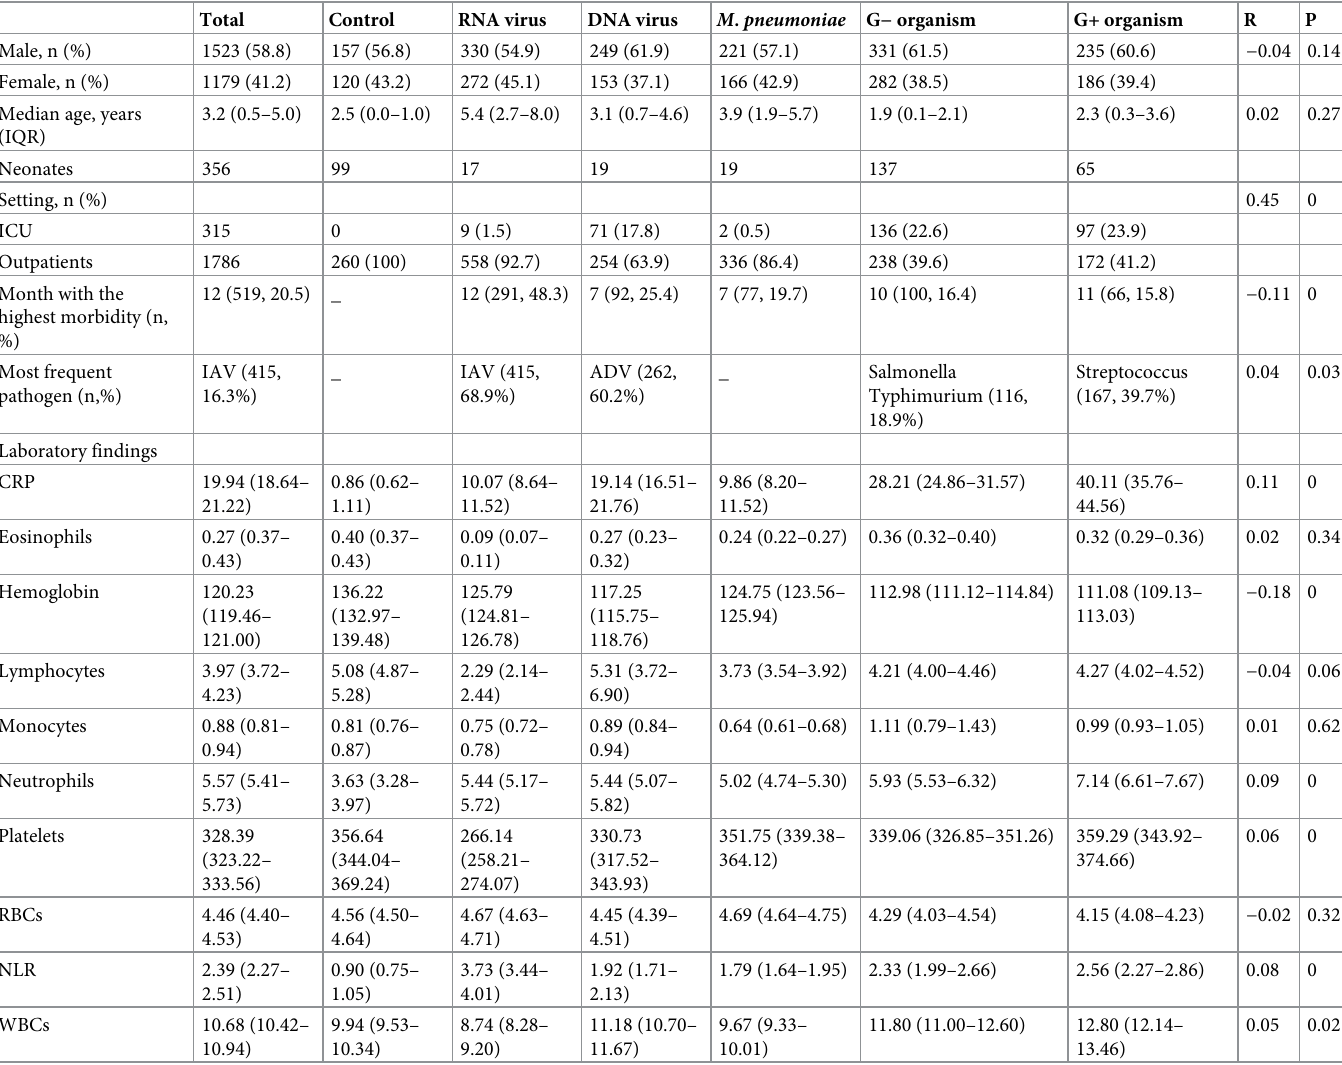
Table 1. Demographic and clinical characteristics of patients infected with RNA viruses, DNA viruses, M . pneumoniae , G − organisms, and G+